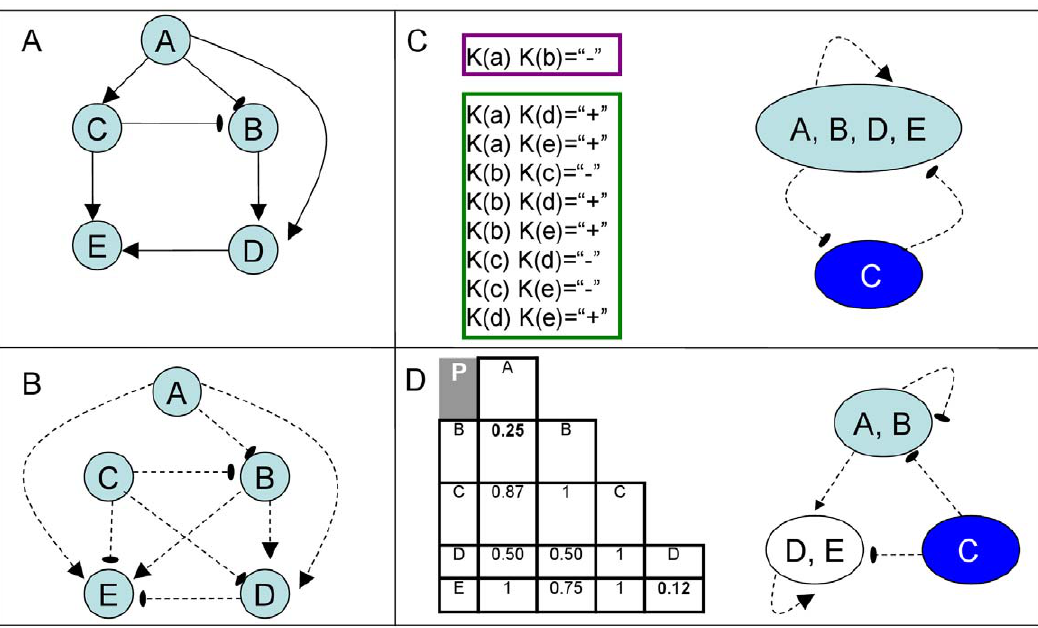
Figure 1. Algorithmic overview. (A) A physical network model with nodes representing proteins and edges representing protein-DNA interactions. The sign of an interaction is denoted by its arrow type: regular (activating) or cut (suppressing). Note that the network is not sign-consistent since for example, A is linked to D by two paths with different aggregate signs. (B) A functional network generated by the physical network (every knockout effect is explained by at least one path in the physical network, see Methods) with edges representing knockout effects and nodes representing the respective genes. The sign of a functional edge is denoted by its arrow type: regular (down-regulation) or cut (up-regulation). (C) The sign-linear algorithm. The functionalnetwork is translatedintoa set of Booleanequations.One optimalsolutionfor the equations issetting k ( c ) to z and the restto { , satisfyingall equations (green frame, bottom) but one (purple frame, top). The ensuing partition into two groups is depicted with edges corresponding to functional relations between groups. This partition can be used for predicting new knockout effects. (D) The sign-clustering algorithm. For each pair of nodes the presented p -value reflects their similarity in the functional network. A partition into clusters using a cutoff of p v 0 : 5 is depicted with edges defined as in panel C. This partition refines the one obtained by the sign-linear algorithm (3 groups instead of 2), correctly modeling all the knockout effects.